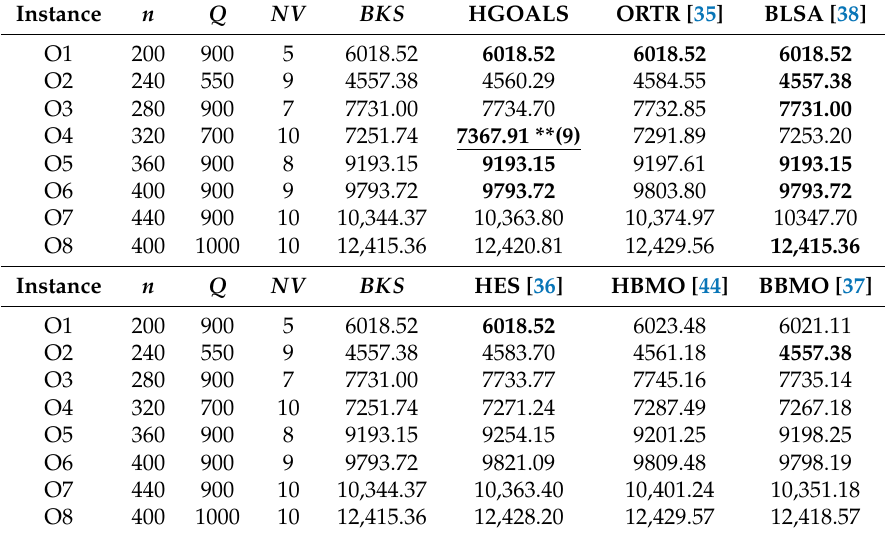
Table 4. Comparison between route decoder and previous research for instances in group O (hierarchical objective function).